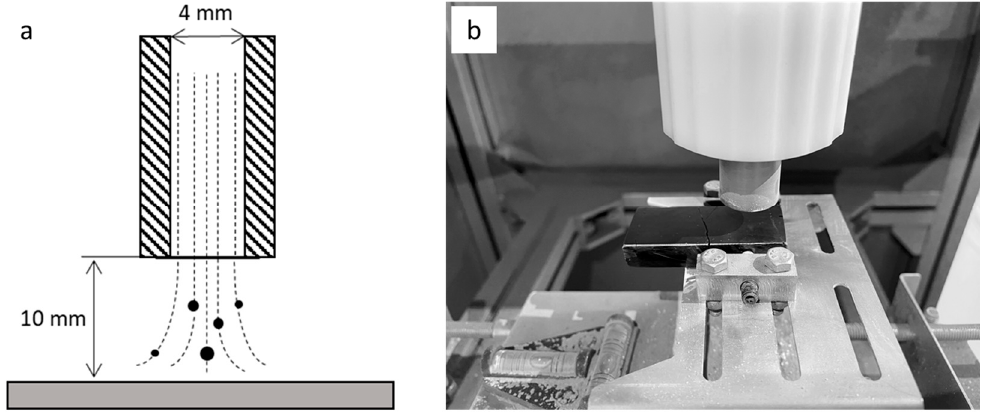
Figure 2. ( a ) Sample and nozzle setup, ( b ) image of the erosion sample on the sliding and tiltable table. Three different erosion times, i.e., 30 min, 60 min, and 90 min, were investigated. For each condition, five samples were tested. After each erosion test, the sample was ultrasonically cleaned in acetone to remove any traces of the erodent powder. The erosion resistance was evaluated from the mass loss, computed by weighing each specimen before and after the erosion test. A Kern ABT 100-5NM (Kern, Balingen, Germany) analytical balance, with an accuracy resolution of 0.01 mg was used.